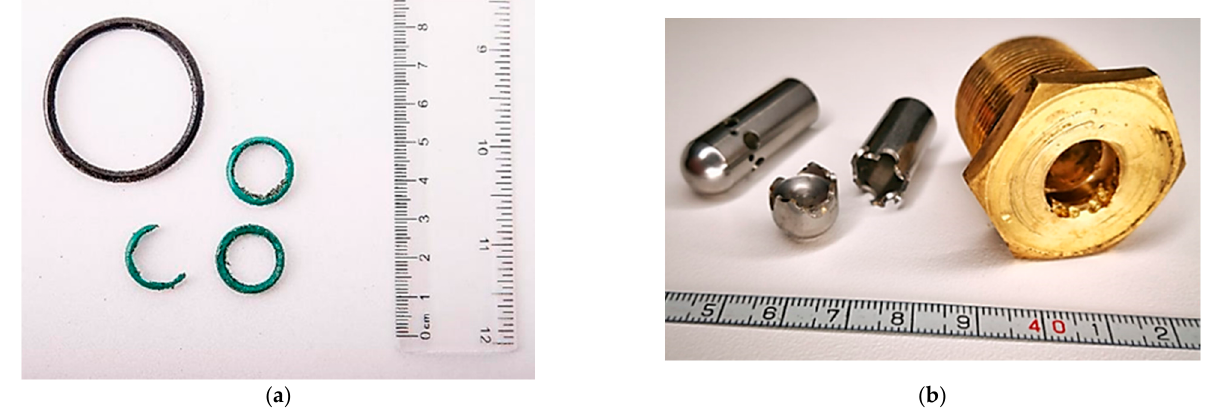
Figure 4. Examples of overflow valve damage: ( a ) damaged O-rings, ( b ) damaged pistons.